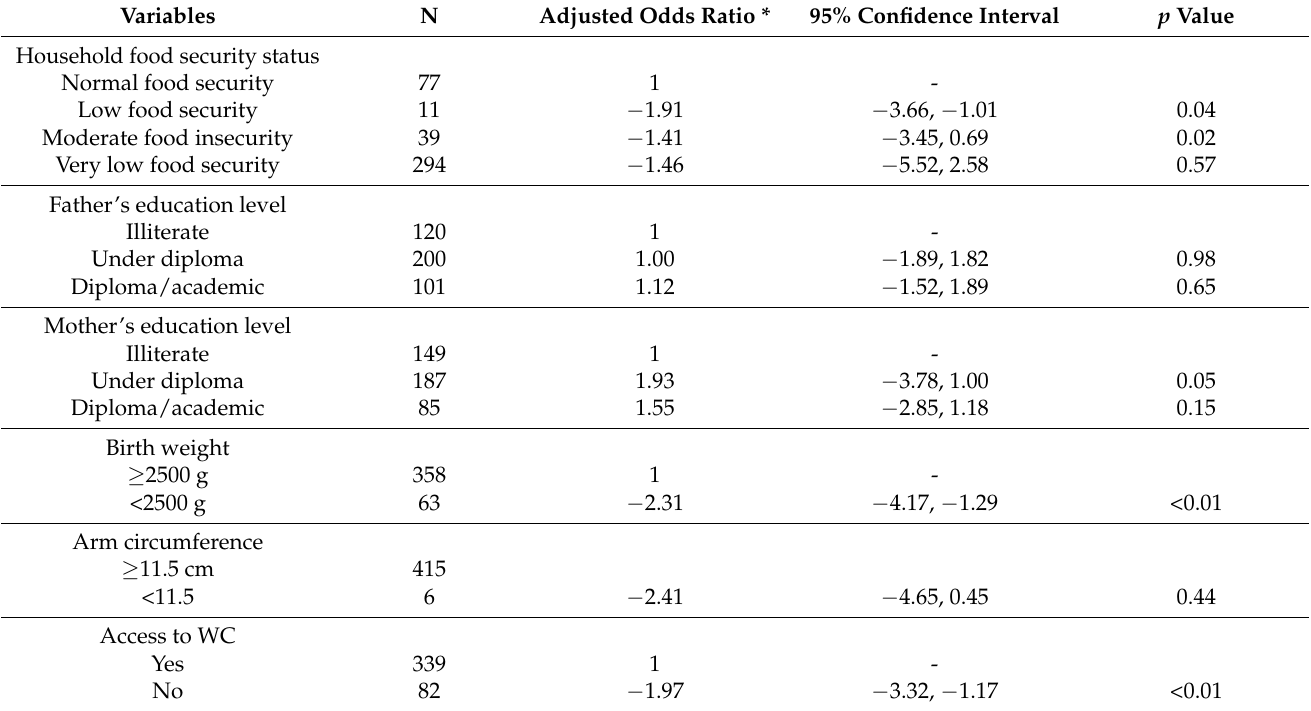
Table 5. Odds ratios of height for age based on the ordinal logistic regression model.